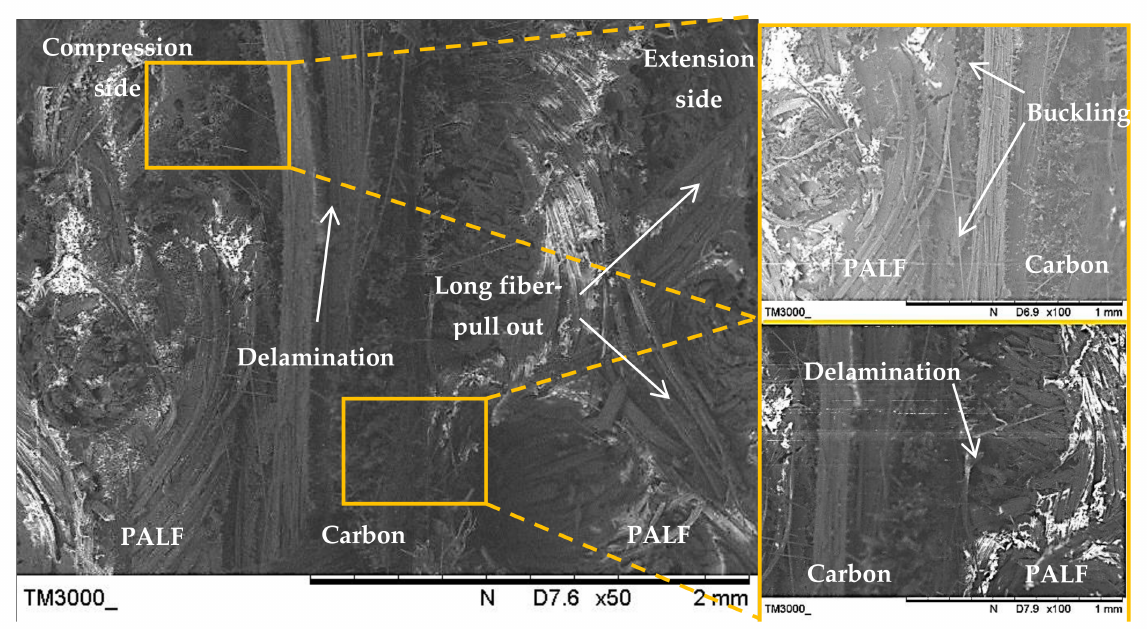
Figure 14. Scanning electron microscope images of the laminate with a carbon ply interior (PCCP) and ply orientation [0 ◦ , 90 ◦ ].